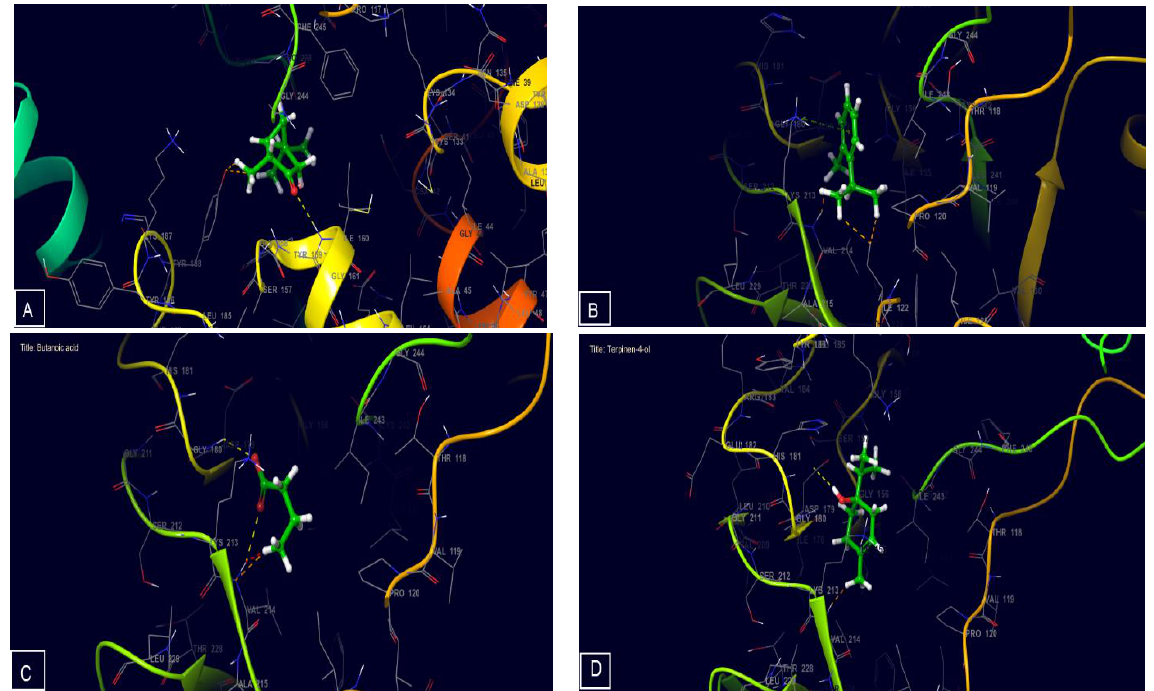
( B ) o-Cymene; ( C ) Butanoic acid; ( D ) Figure 4. 3D diagrams of ligands interactions with the active site of NADPH. ( A ) Thujone; ( B ) o- Cymene; ( C ) Butanoic acid; ( D ) Gamma-terpinene.